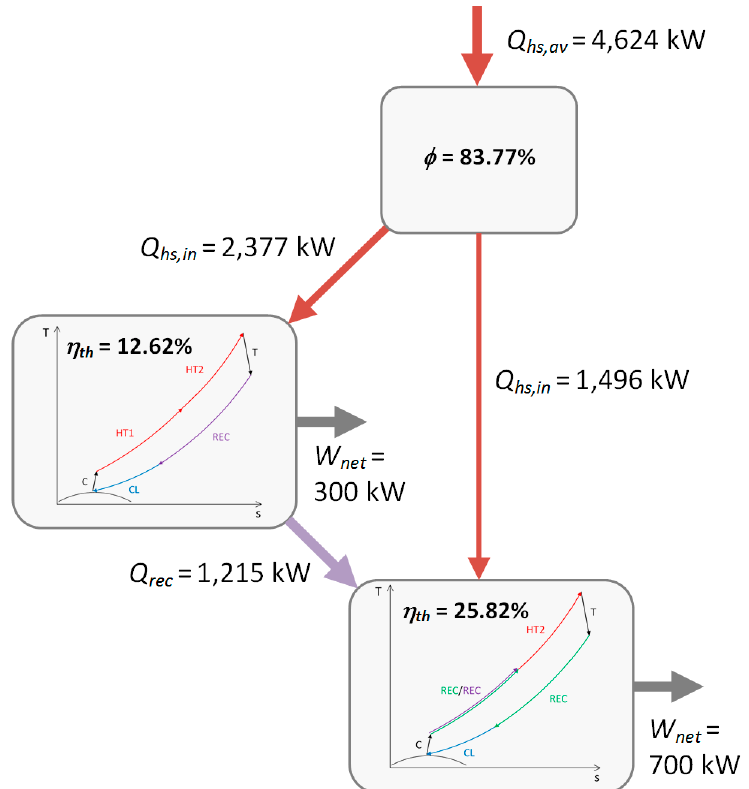
Figure 12. Partial heating cycle. Breakdown of the overall performance into a chain of efficiencies, which include the thermal efficiencies of the elementary